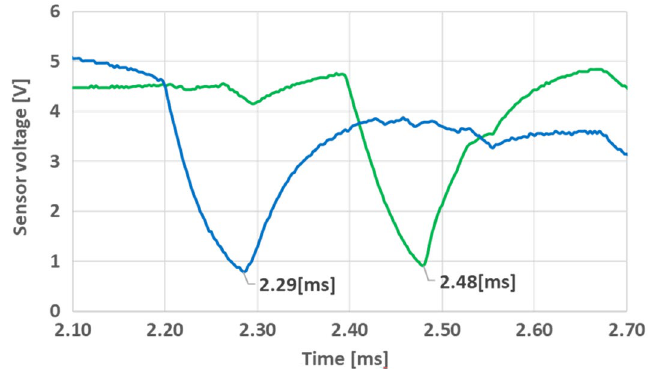
Figure 11. The sensing voltage detection for seven stage launching velocity, represents velocity of 131.5